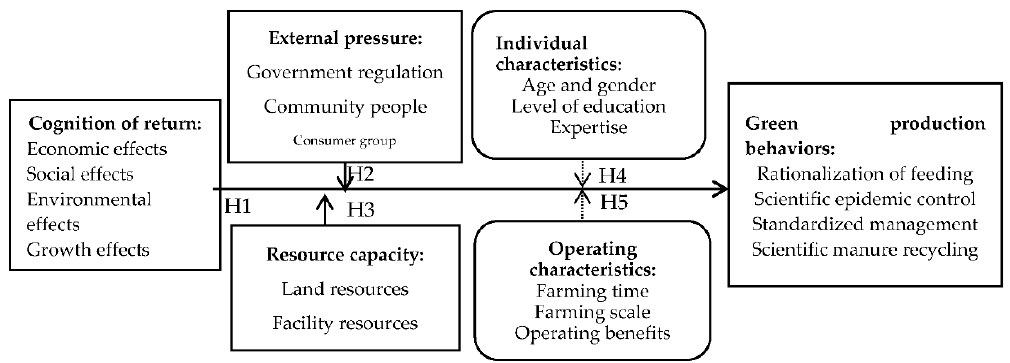
Figure 1. Influencing Factors of the Green Production Behaviors of Farmers.